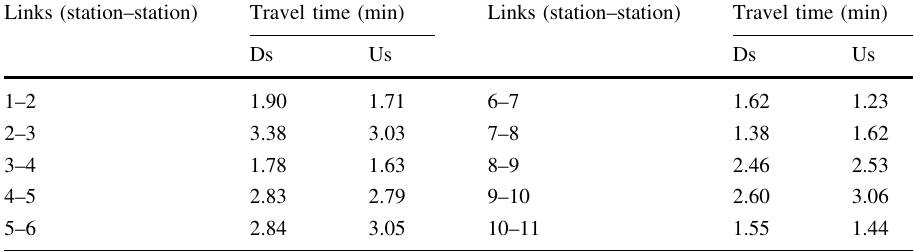
Table 3 Travel time for various links on line 1 during peak hours